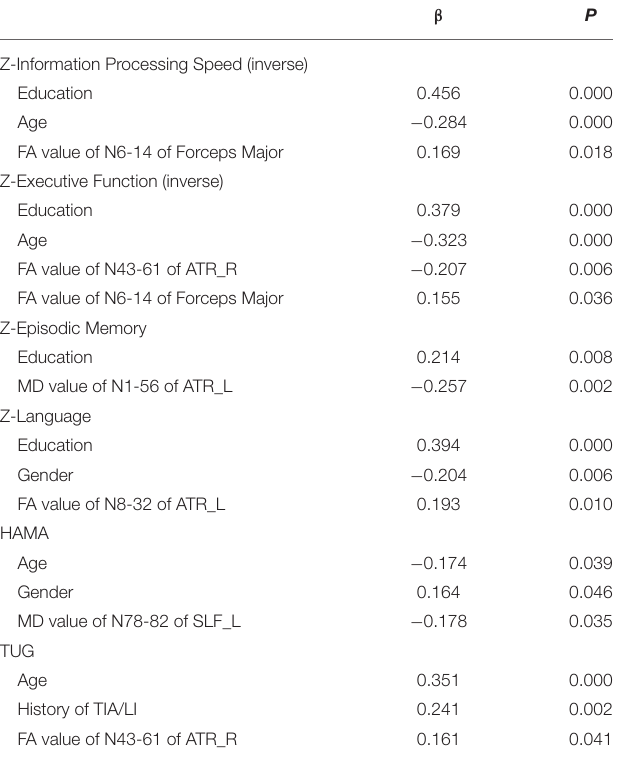
TABLE 4 | Multiple linear regression